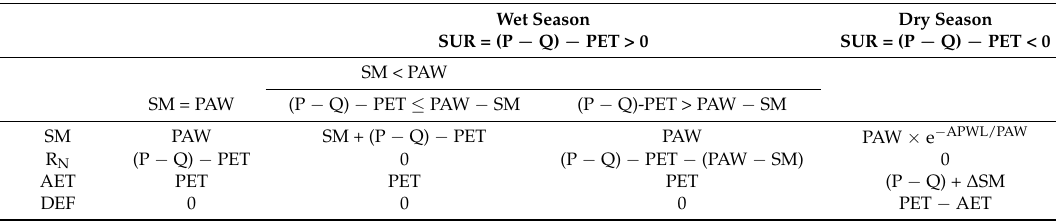
Table 4. Annual soil-water budget calculations (after